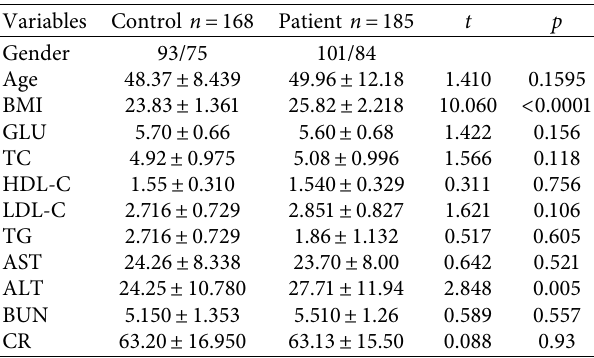
Table 1: Te sample demographic information in this study. Variables Control n � 168 Patient n �